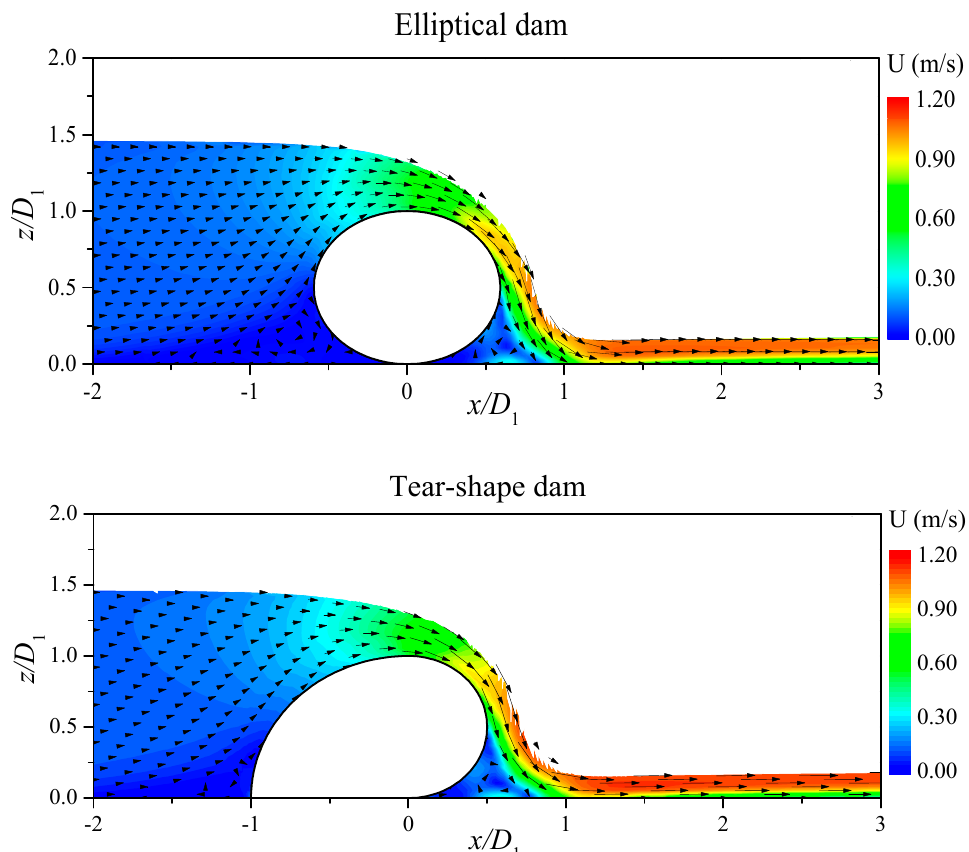
Figure 14. Comparison of the simulated water depths for the circular, elliptical, and tear-shape dams.